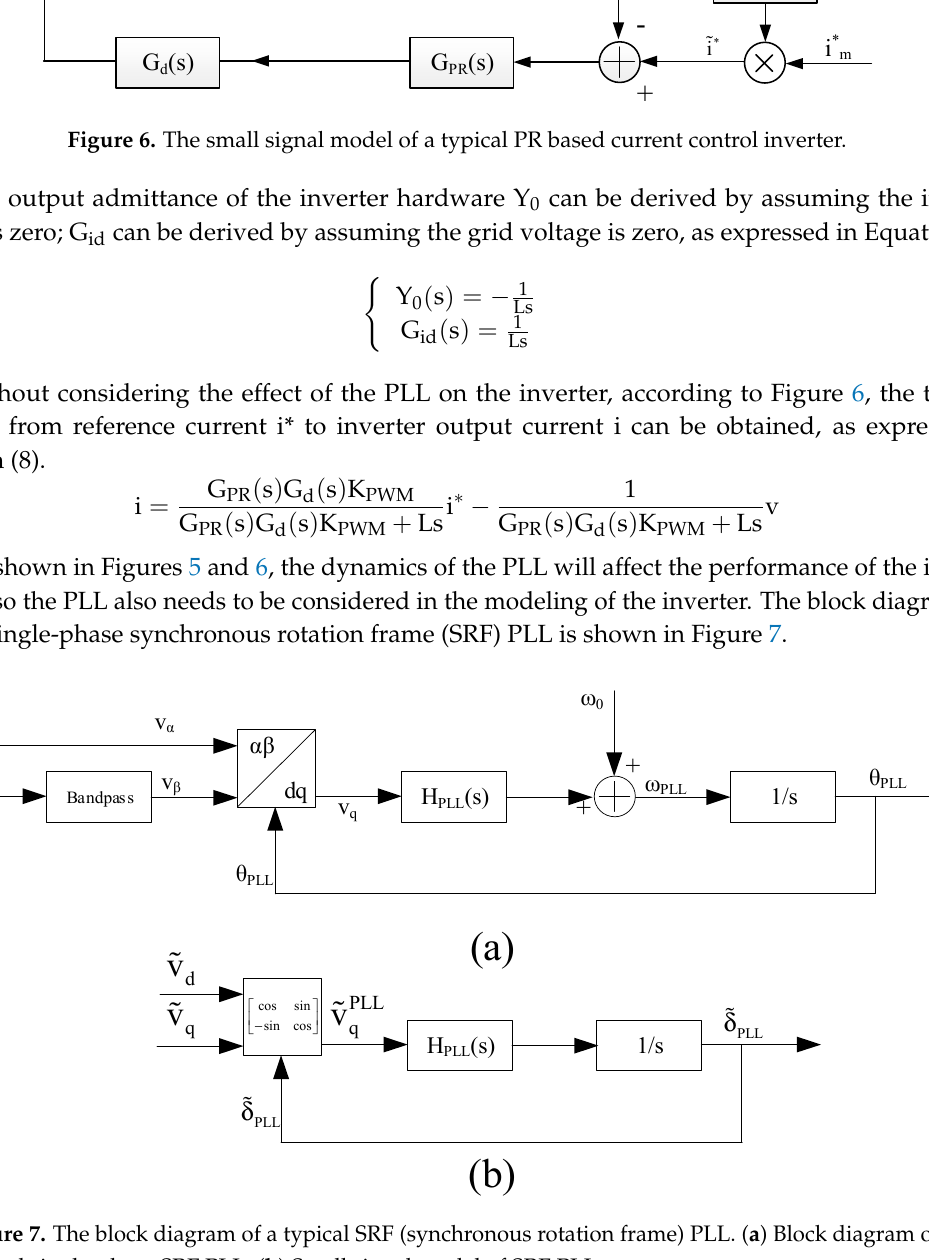
Figure 6. The small signal model of a typical PR based current control inverter.